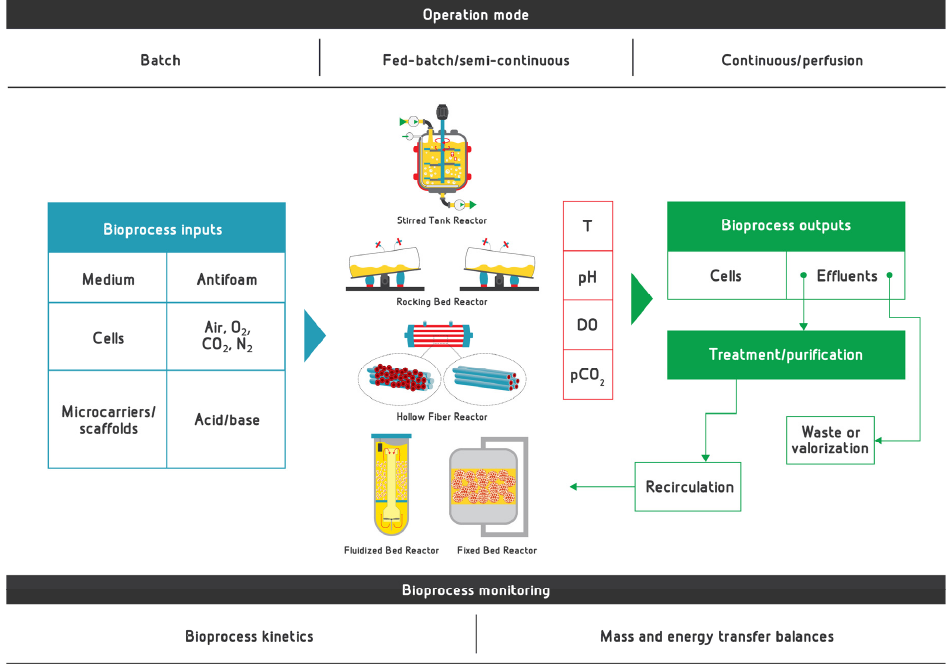
Figure 2. General considerations for bioprocess aimed at cultivated meat